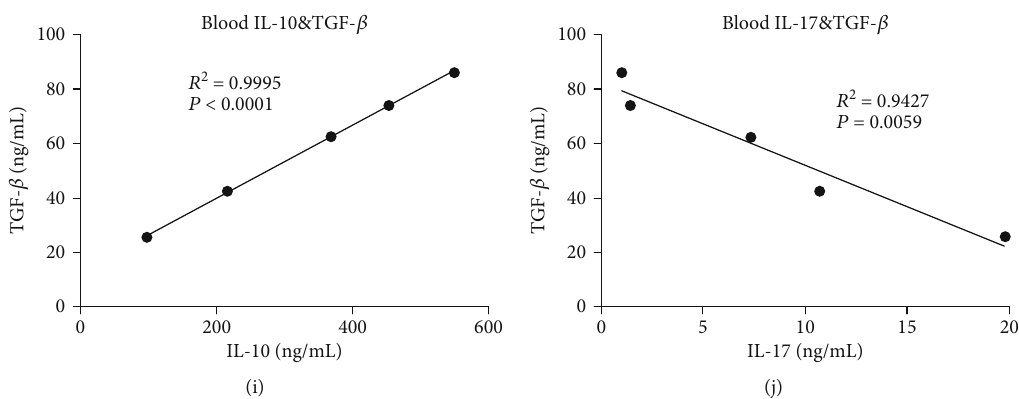
Figure 6: The correlation analyses of cytokines from peripheral blood were analyzed in allogenic o ff spring after transferring CD4 + CD25 + FoxP3 + Tregs: (a) IFN- γ and IL-4, (b) IFN- γ and IL-10, (c) IFN- γ and IL-17, (d) IFN- γ and TGF- β , (e) IL-4 and IL-10, (f) IL- 4 and IL-17, (g) IL-4 and TGF- β , (h) IL-10 and IL-17, (i) IL-10 and TGF- β , and (j) TGF- β and IL-17 from peripheral blood of o ff spring mice with Treg cells transferred in VD3 administration were analyzed for their